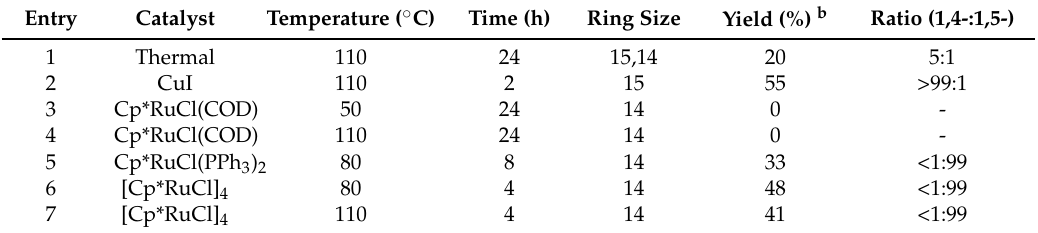
Table 1. Macrocyclization with azide-alkyne cycloadditon a .